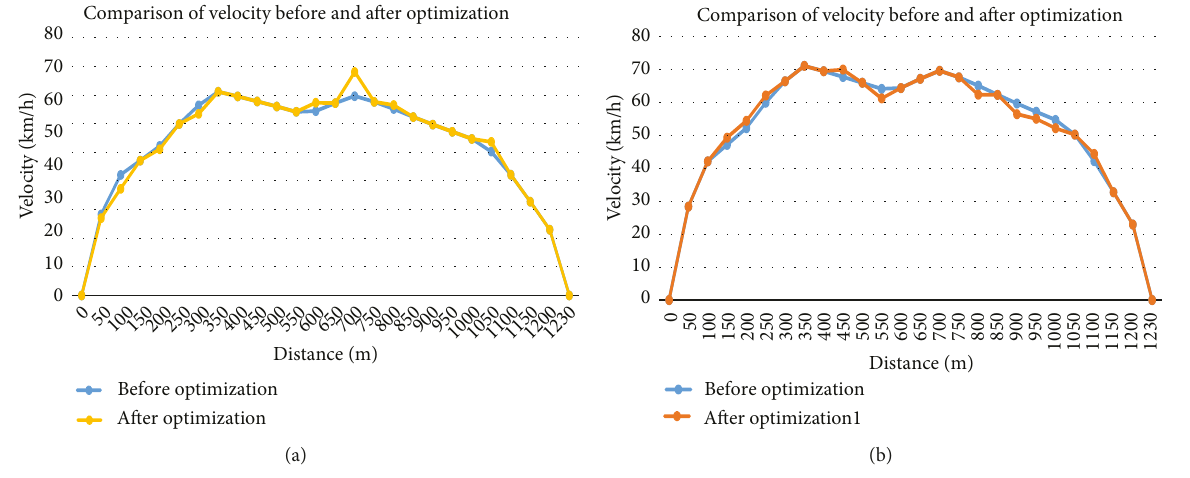
Figure 16: Optimization results with big intervals. (a) m=50%. (b)